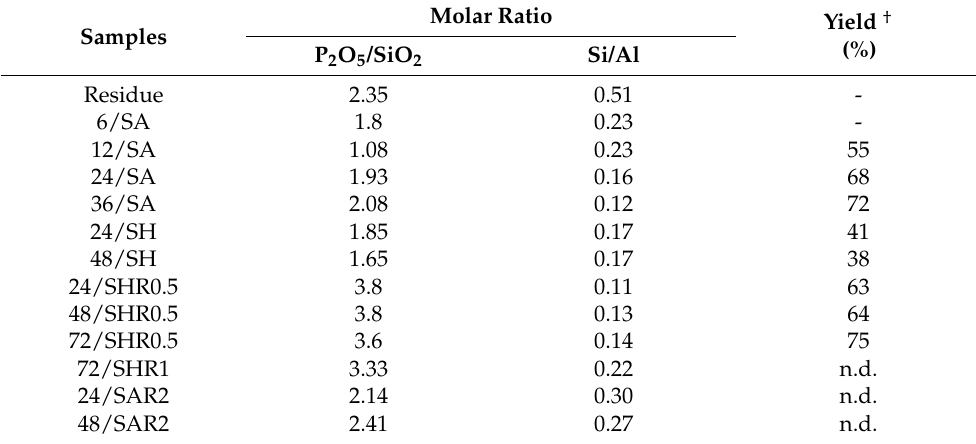
Table 3. Molar ratios and yield for the